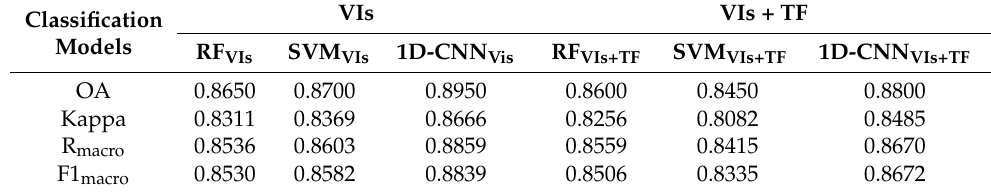
Table 3. Accuracy evaluation of classification models for different damage levels of forest trees.